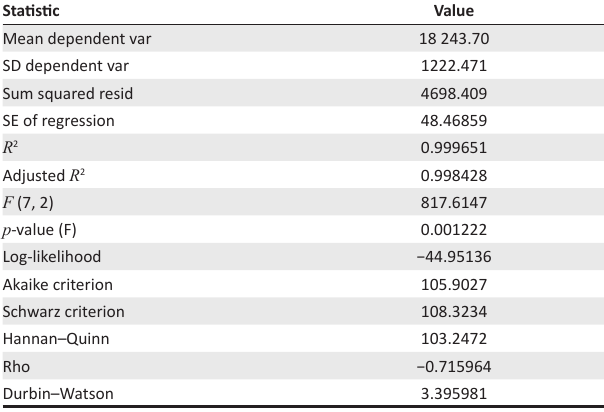
TABLE 2b: Summary statistics for accident count model.